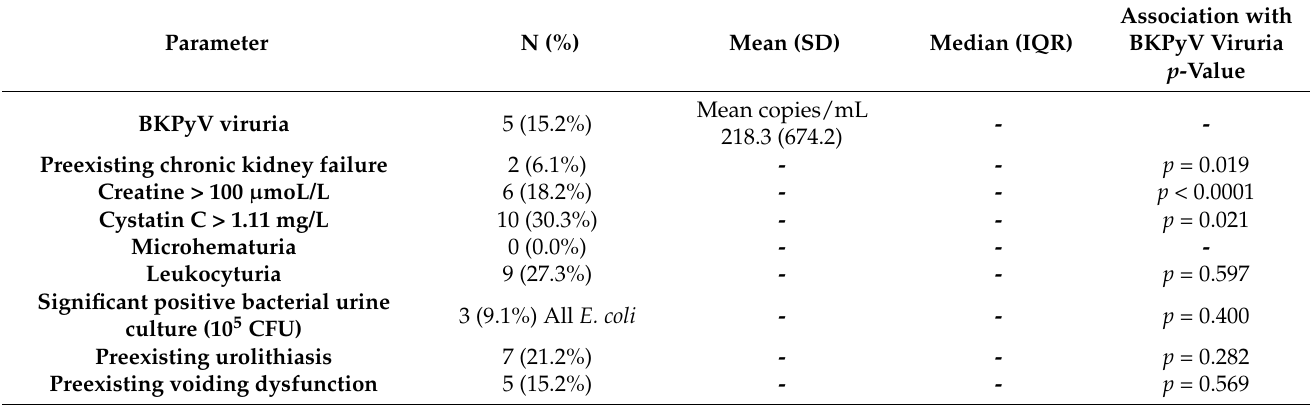
Table 2. Urogenital infections, kidney function, and association with BKPyV viruria (n = 33).